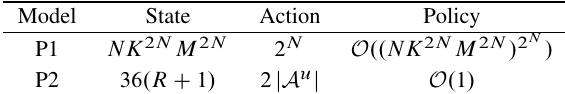
Table 1 Comparison between P1 and